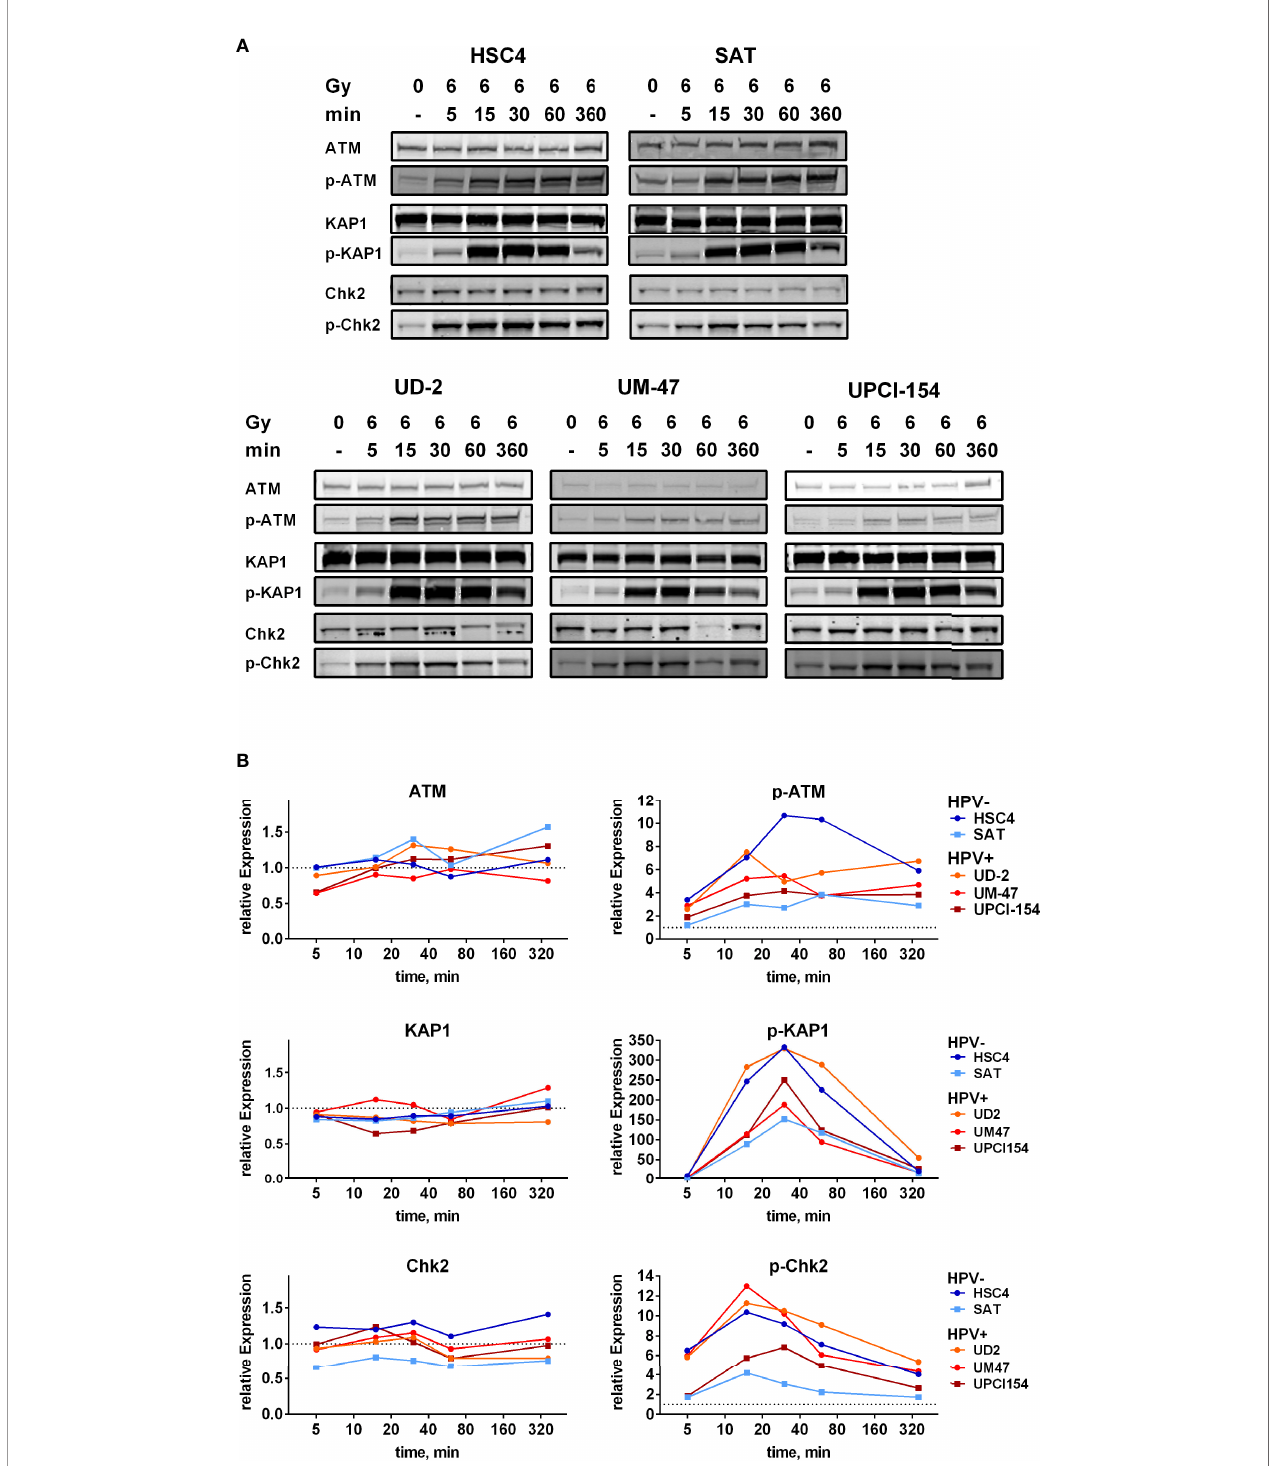
FIGURE 5 | Phosphorylation kinetics of ATM target proteins. Exponentially growing cells were irradiated with 6 Gy and harvested in sample buffer at the indicated time points. (A) Western blot signals. (B) Quanti fi cation. Data points represent the mean of two independent experiments. Left: whole protein level. Right: phosphorylation. Dotted lines indicate the normalized signal intensity of the non-irradiated